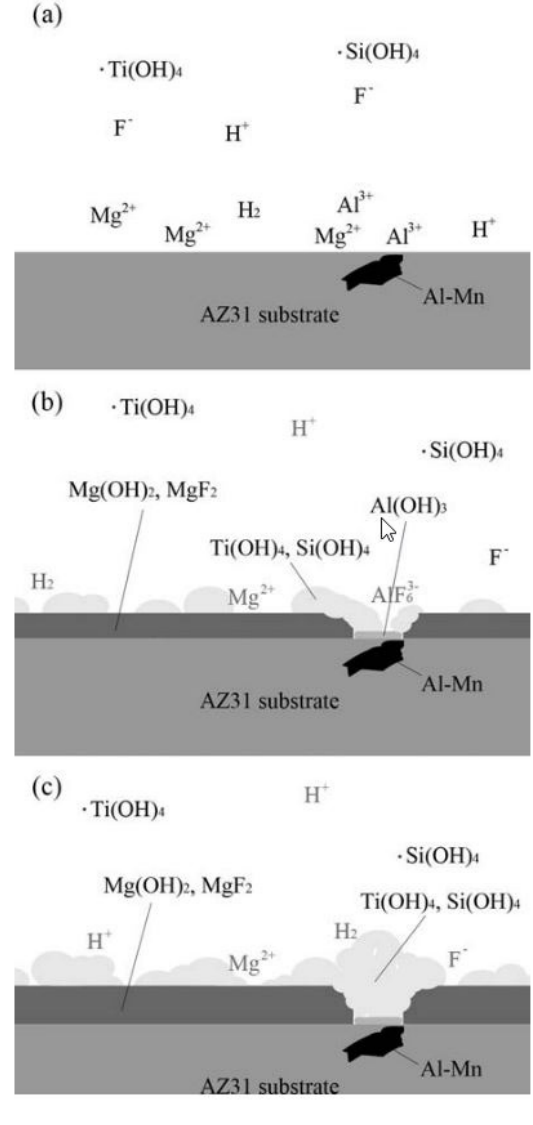
Figure 14. A schematic representation showing the titanate conversion coating formation on the AZ31 alloy: ( a ) the dissolution of Mg and Al as well as the discharge of hydrogen; ( b ) the formation of the porous layer composed of Mg(OH) 2 and MgF 2 as well as local precipitation of Si(OH) 4 and Ti(OH) 4 on top of the porous layer; and ( c ) the growth of the porous layer and the Si(OH) 4 and Ti(OH) 4 precipitates. Reprinted from [125] with permission from IOP.